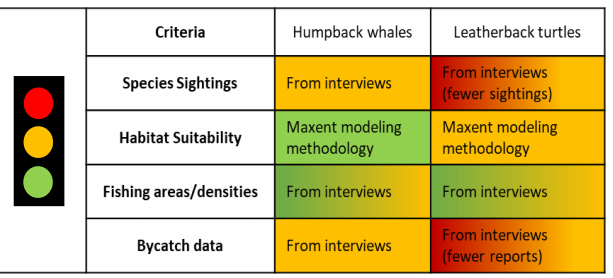
TABLE 3 | We assigned uncertainty signals using the stoplight approach from Hines et al. (2020).